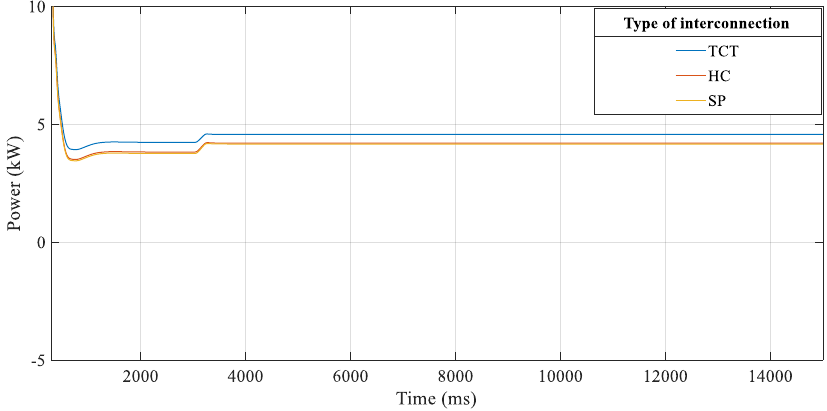
Figure 19. Impact of open- circuit fault ‘F1′ on power grid (monocrystalline PV).